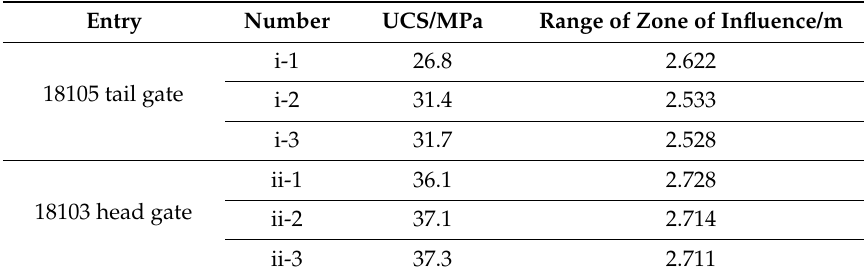
Table 2. Failure scope of surrounding rock with different